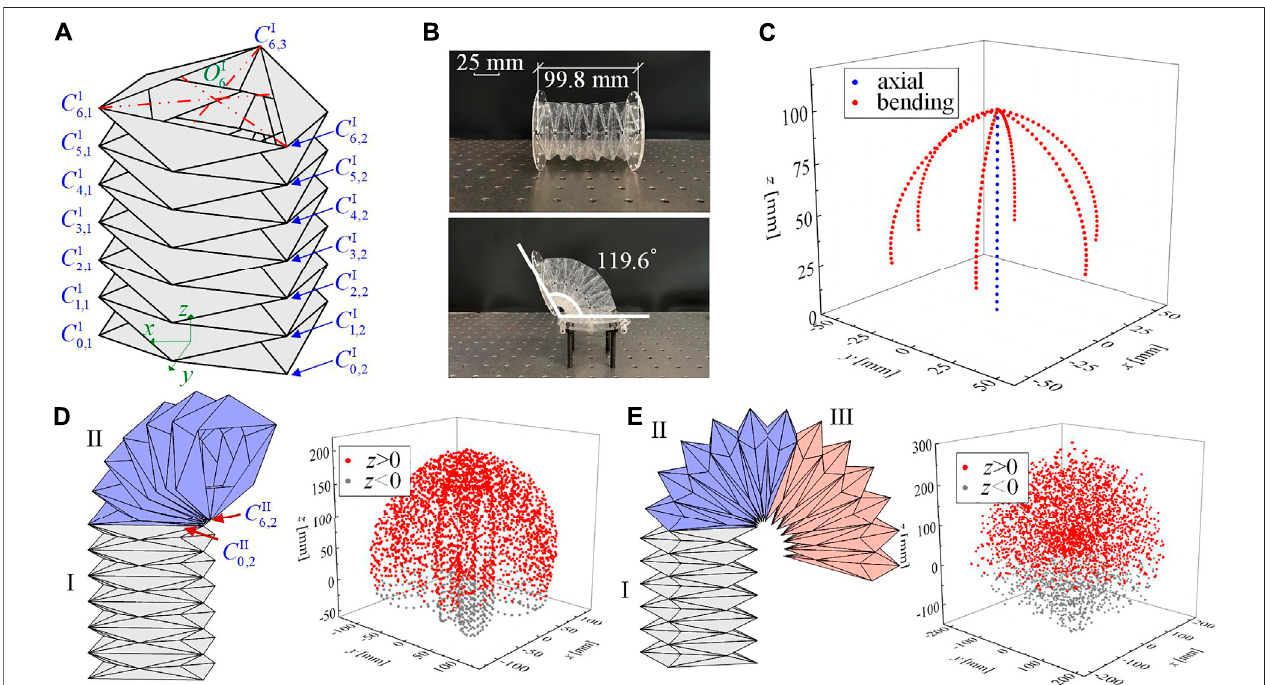
FIGURE 6 | Geometry of a multi-layer Yoshimura-ori structure and its reachable workspace. (A) A six-layer Yoshimura-ori structure. (B) A six-layer Yoshimura-ori structure prototype. The top one displays acon fi guration without deformation, with its originallength being 99.8 mm; the bottom one displays the con fi guration with the maximum reachable bending angle 119.6 ° . (C) The reachable workspace of the six-layer Yoshimura-ori structure. (D) The geometry of a two-segment Yoshimura-ori structure and the corresponding reachable workspace. (E) The geometry of a three-segment Yoshimura-ori structure and the corresponding reachable workspace. The excellent 3D deformability is also demonstrated via